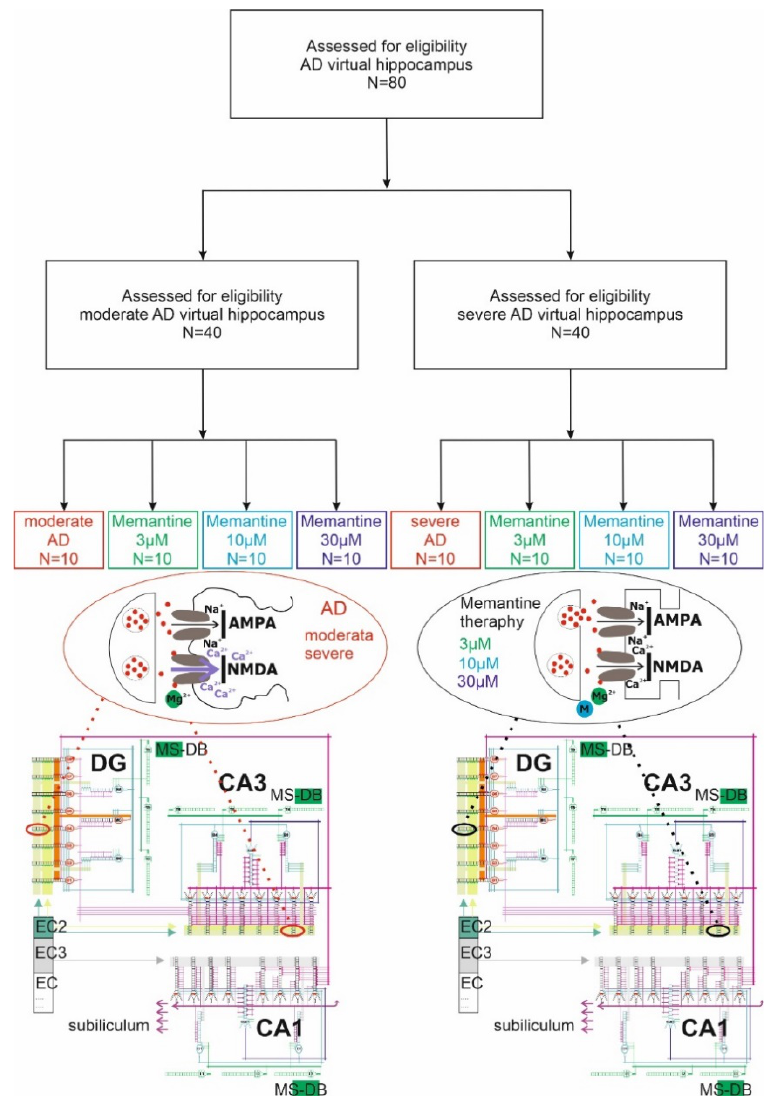
Figure 4. Simulation diagram of hippocampal network. Each group was randomised to one of four subgroups, where one was a control and the other three received virtual memantine therapy at doses of 3 µM (green), 10 µM (blue) and 30 µM (violet). Activation of the receptor caused by neurotoxic factors results in the release of Mg 2+ and an uncontrolled influx of Ca 2+ into the cell—red circle on the left. The depolarization caused by a strong stimulus is sufficient to remove the blockade of the memantine channel and to allow the influx of calcium ions into the cell—black circle on the